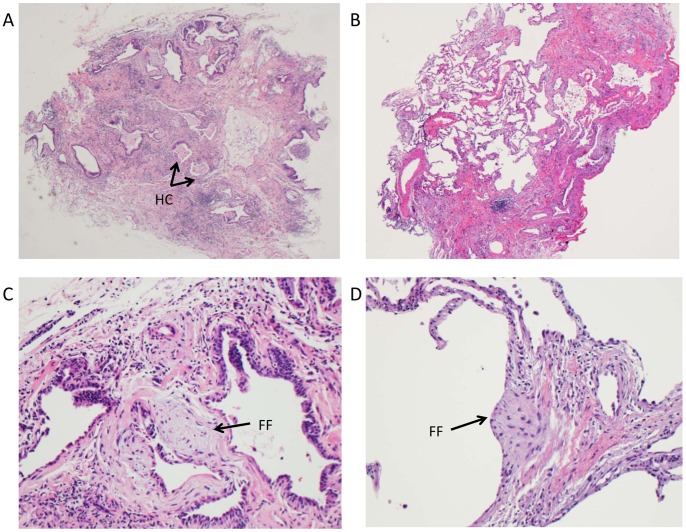
Cryobiopsy demonstrates typical features of UIP/IPF.Representative cryobiopsy samples from subjects with UIP demonstrating (A) dense scar with microscopic honeycomb cysts (HC), (B) Temporal heterogeneity, and (C–D) Fibroblastic foci (FF). A and B original magnification 40×, C-D 400×.